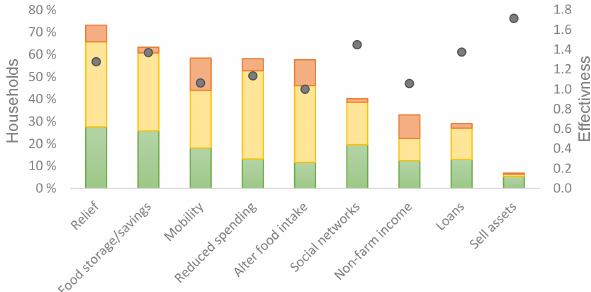
Figure 3. Uptake and effectiveness (effectiveness scores were cal- culated as “effective” · 2 + , “marginally effective” · 1 + and “non- effective · 0) of coping